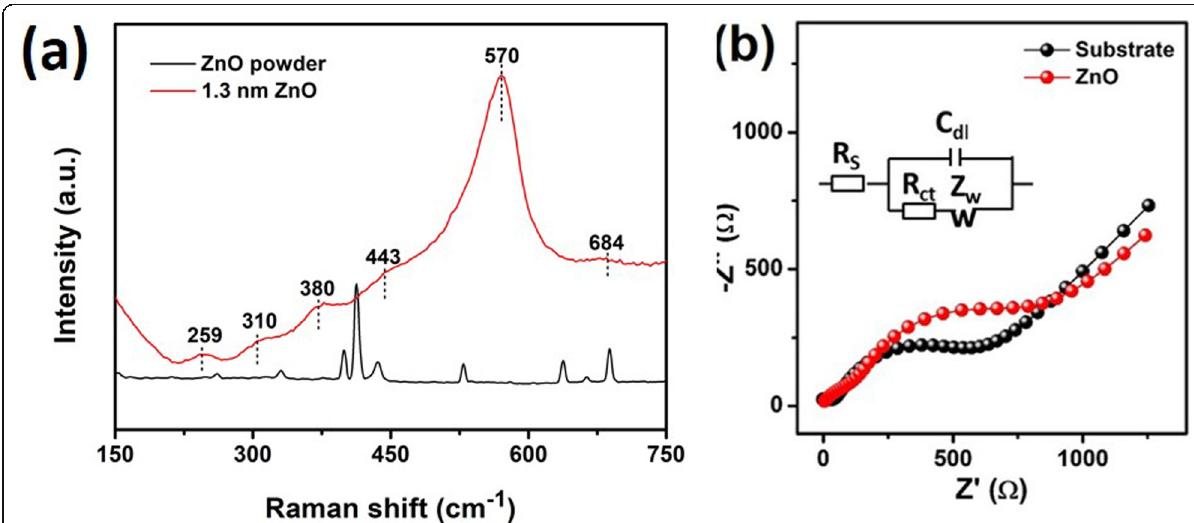
Fig. 4 a Raman spectra at 25 °C for ZnO powder and ALD-developed ZnO with thickness 1.3 nm. b Nyquist plots of the blank substrate and ZnO with 5 mM K 4 Fe(CN) 6